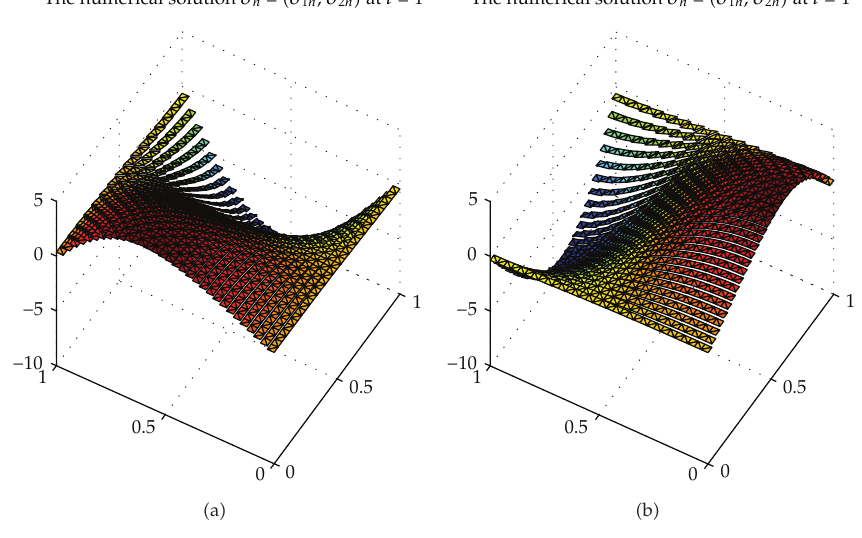
Figure 6: The numerical flux σ 1 h (cid:3) a (cid:4) and σ 2 h (cid:3) b (cid:4)